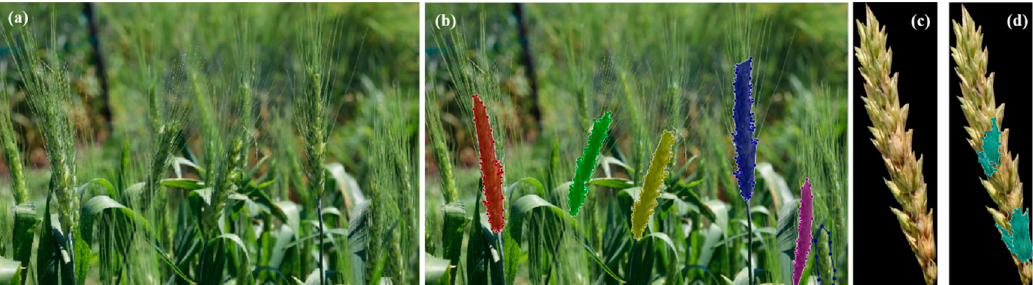
Figure 1. An example of manual annotation of images: ( a ) a typical full-size image of spikes from a single planted row of wheat in the field; ( b ) the same image with annotated wheat spikes; ( c ) a segmented sub-image of a single wheat spike; ( d ) the individual wheat spike with annotated diseased